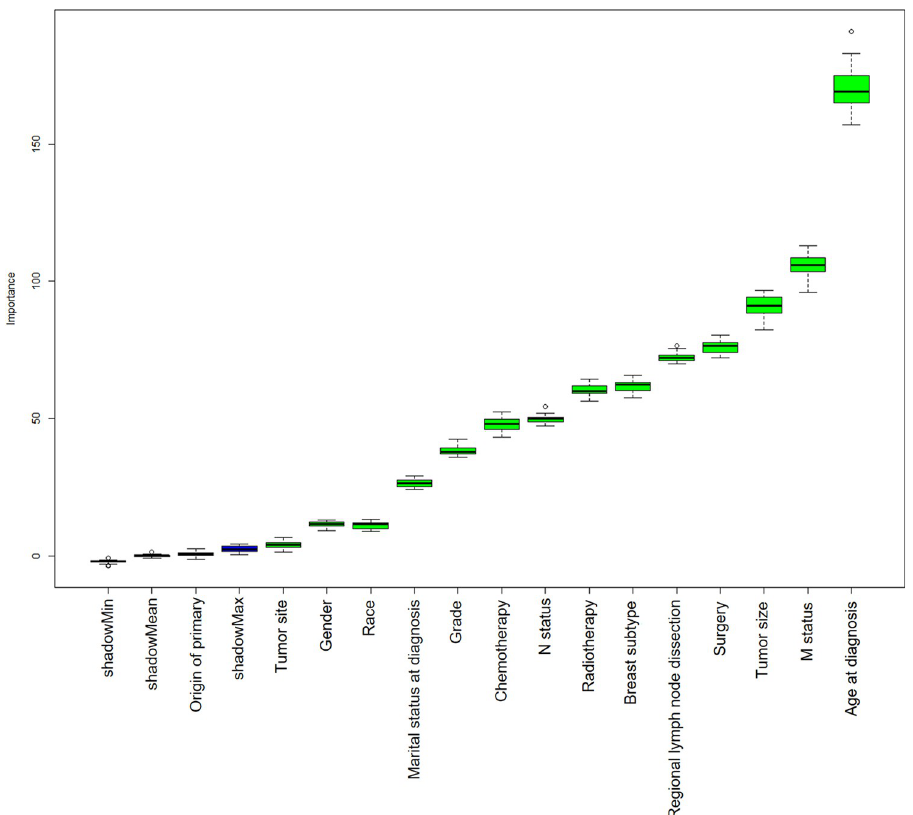
Fig 2. Feature selection for the 10 ML